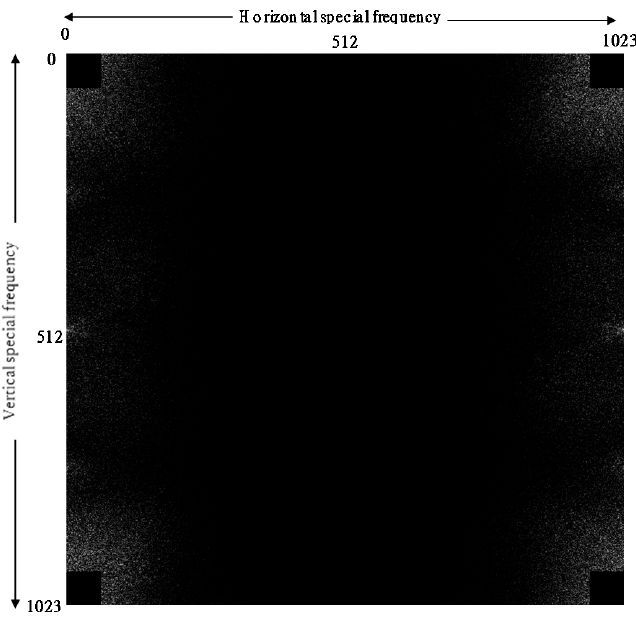
Figure 5. Two-dimensional auto correlation in frequency domain.